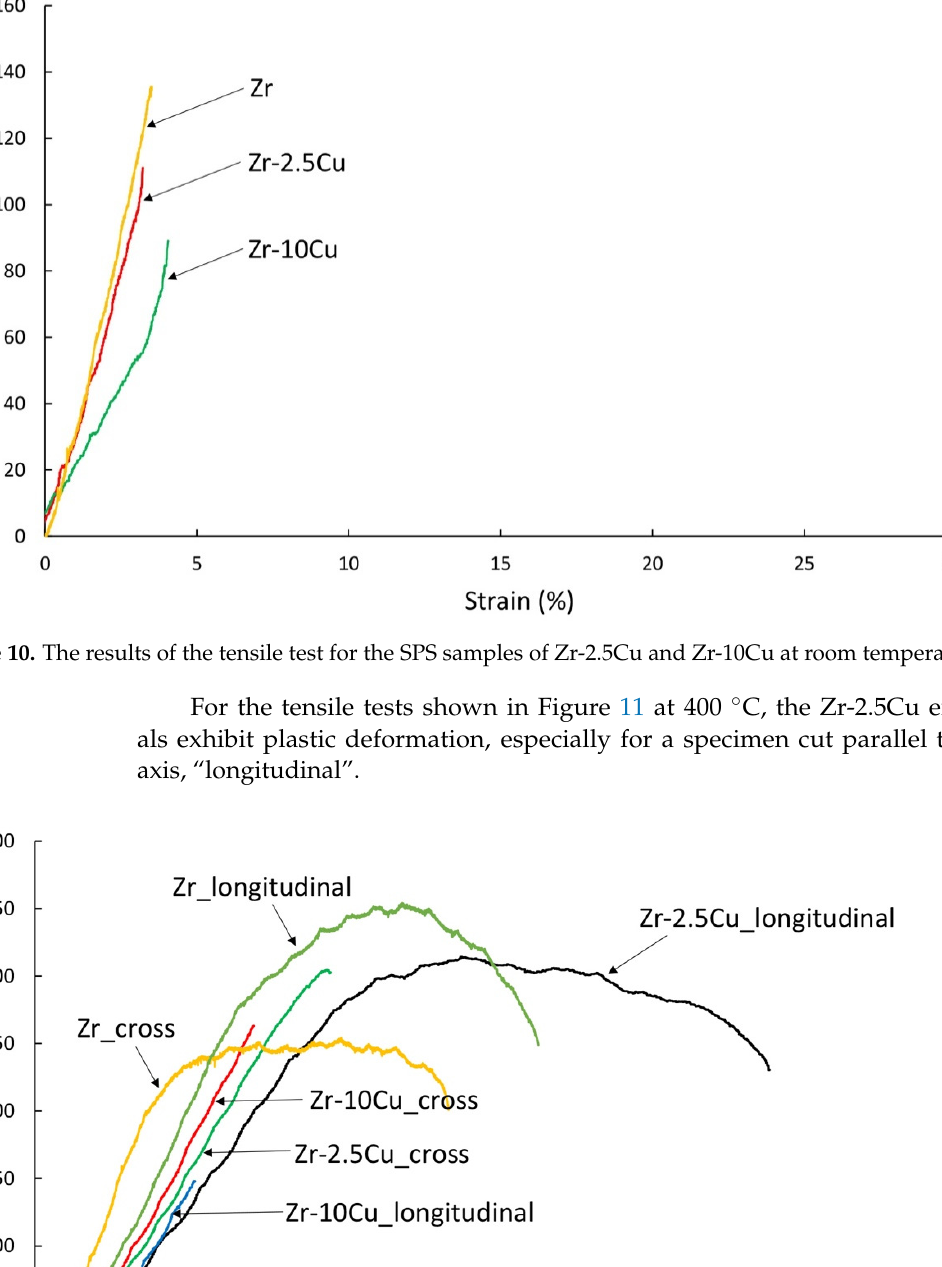
Figure 12. Fractography of tensile fracture surfaces for: ( A ) the extruded samples of Zr-2.5Cu and ( B ) Zr-10Cu. The sintered materials in a tensile test at 400 °C behave similarly to extruded materi- als (Figures 12 and 13). The material with 2.5% Cu showed the greatest plastic defor- mations (Figure 13). The sintered material shows less strain compared to extruded mate- rials (Figure 12).